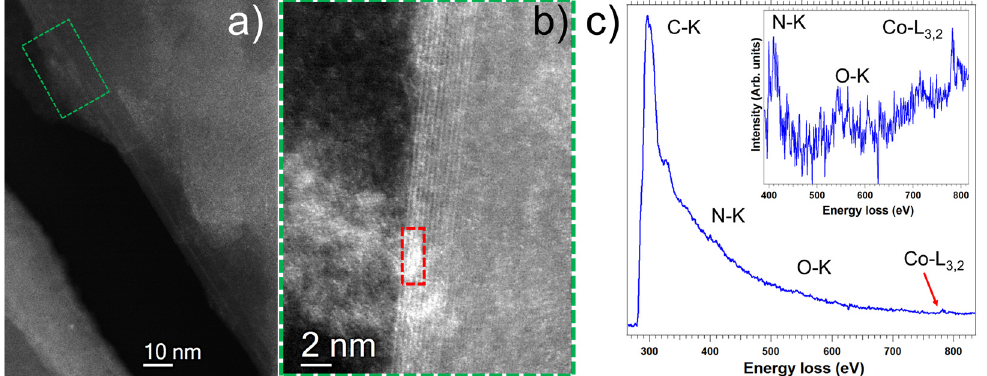
Figure 7. ( a,b ) HAADF-STEM micrographs of [Co]-imi-graphene recorded on one graphene flake. An EELS spectrum-image has been acquired on the red marked area highlighted. ( c ) The EEL spectrum corresponds to the sum of 24 EEL spectra recorded in this red marked area. The C-K, N-K, O-K and Co-L 3,2 edges are clearly observed.